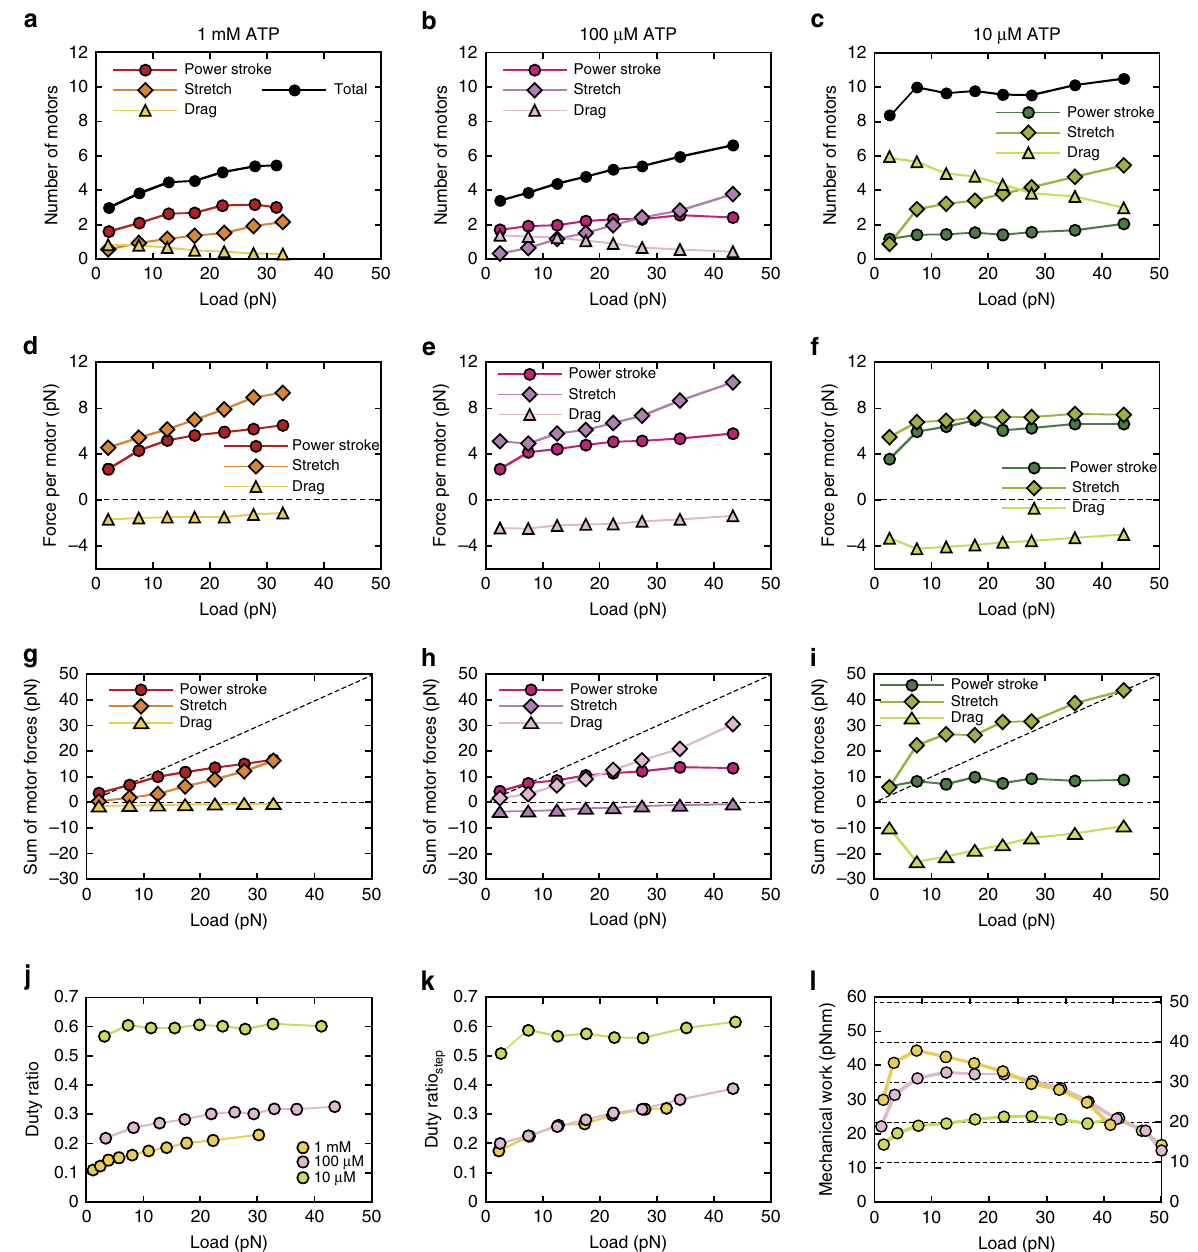
Figure 7 | Load-dependent modulation of coordinated-power stroke stretched and drag motors. ( a – c ) The mean numbers of coordinated-power stroke, stretched and drag myosin motors as a function of loads obtained from the simulation model at 1mM, 100 m M and 10 m M ATP in a – c , respectively. ( d – f ) Mean force per coordinated-power stroke, stretched and drag myosin motors as a function of the loads at 1mM, 100 m M and 10 m M ATP in d – f , respectively. ( g – i ) Sum of forces generated by coordinated-power stroke, stretched and drag myosin motors at 1mM, 100 m M and 10 m M ATP in g – i , respectively. Diagonal dashed lines represent the force level, which is equivalent to an applied load. The sum of these force curves perfectly aligns to this line. ( j , k ) Duty ratio at 1mM, 100 m M and 10 m M ATP as a function of load calculated by two methods: a ratio of attachment time to cyclic time in j and a ratio of total number of power stroke, stretched and drag motors to 17 motors counted during 200 m s from the onset of detectable steps in k . ( l ) Mechanical work and efficiency at 1mM, 100 m M and 10 m M ATP as a function of load. All mean values are plotted with error bars representing s.e.m., but most error bars are hidden behind